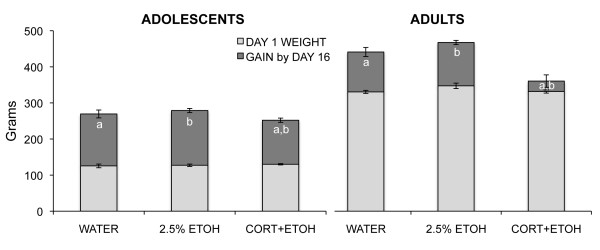
Mean (SEM) weight at postnatal day 45 the last day of treatment for rats ingesting corticosterone dissolved in 2.5% ethanol (CORT-ETOH), 2.5% ethanol (ETOH), or water (WATER). The lighter colored portion of the column represents weight at postnatal day 30, the first day of treatment, and the darker colored portion of the column represents weight gain during the 16 days of treatment. Matched letters indicate significant (P < 0.05) differences between groups in weight gain for adolescent and for adult groups.